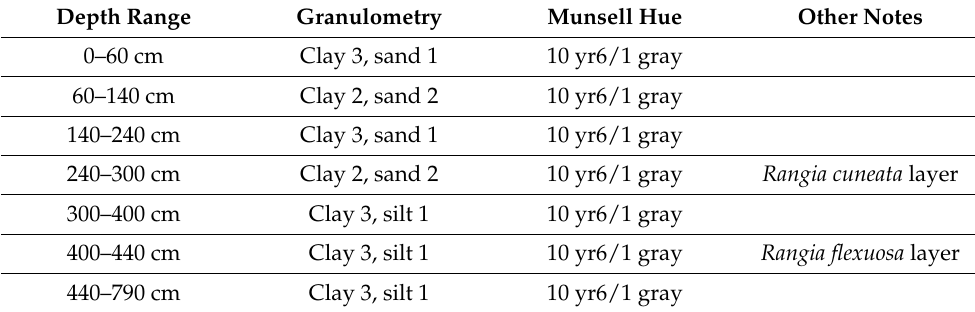
Table 5. Troels-Smith’s description of Nueces Bay (NB) sediments